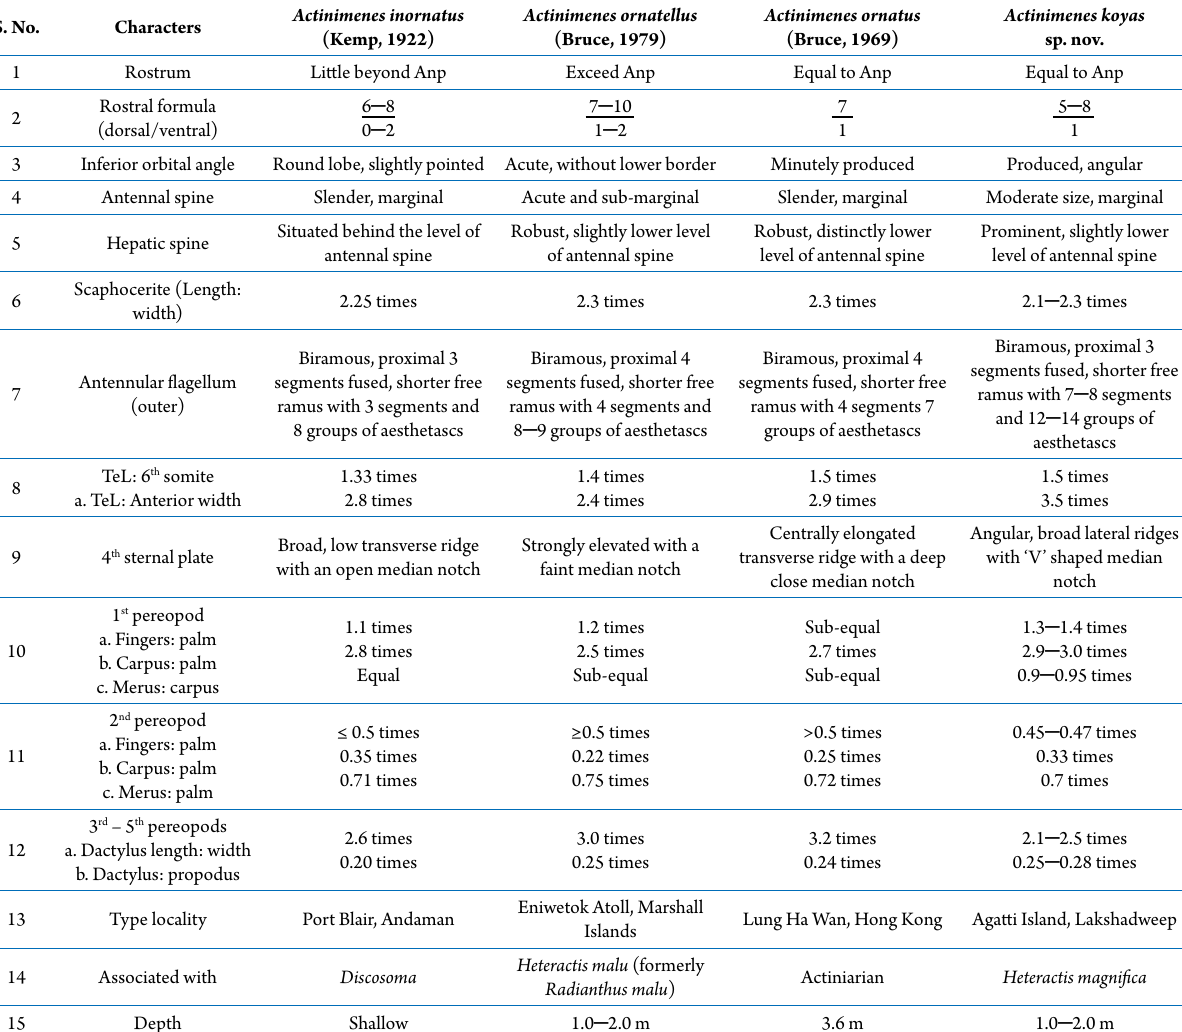
Table 2. Comparison of morphological features of Actinimenes koyas sp. nov. and other Actinimenes spp.: Anp – Antennular peduncle and TeL – Telson length. S.